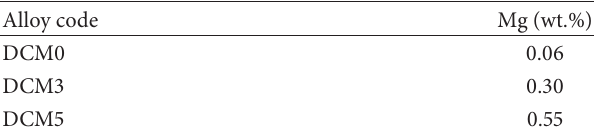
Table 2: Alloy codes and Mg concentration. Alloy code